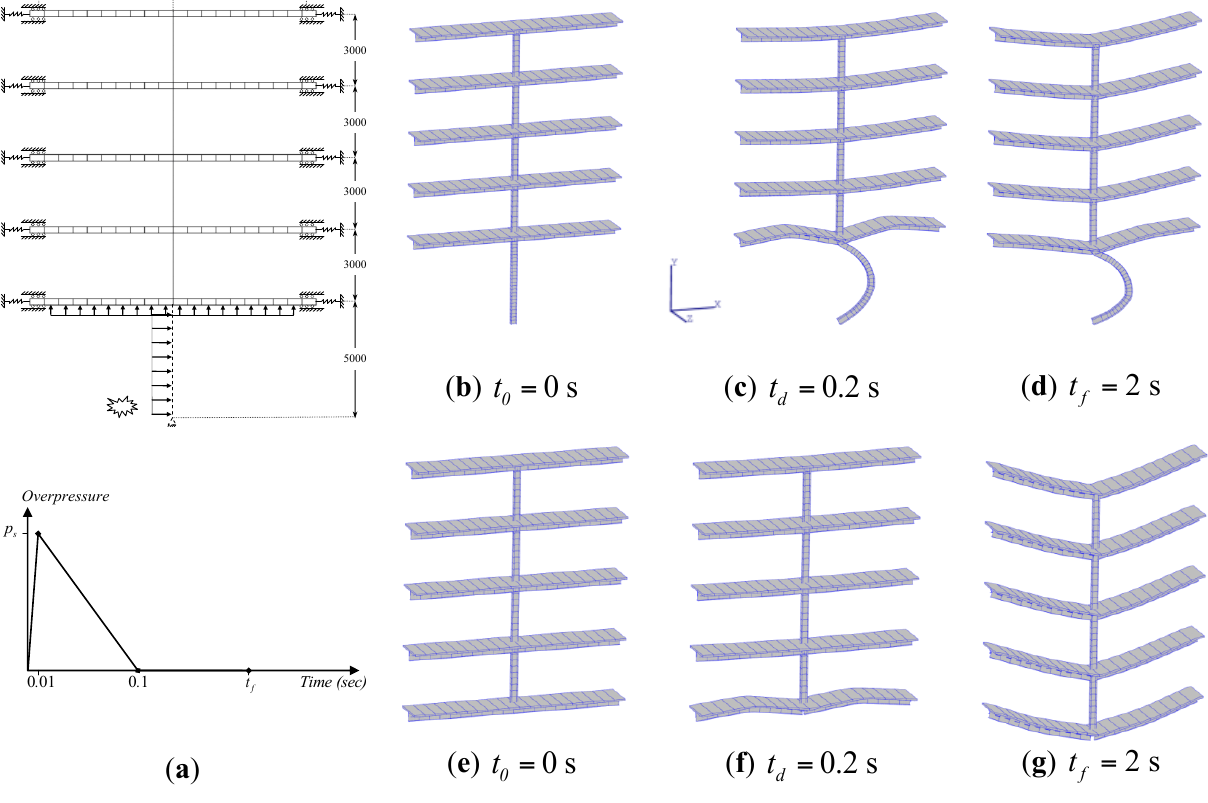
Figure 3. Multi-story building under localized blast. ( a ) Structural configuration (dimensions in mm); ( b–d ) FE time history response for blasted column for UBF = 10; ( e–g ) FE time history response assuming brittle shear failure of the column for UBF =